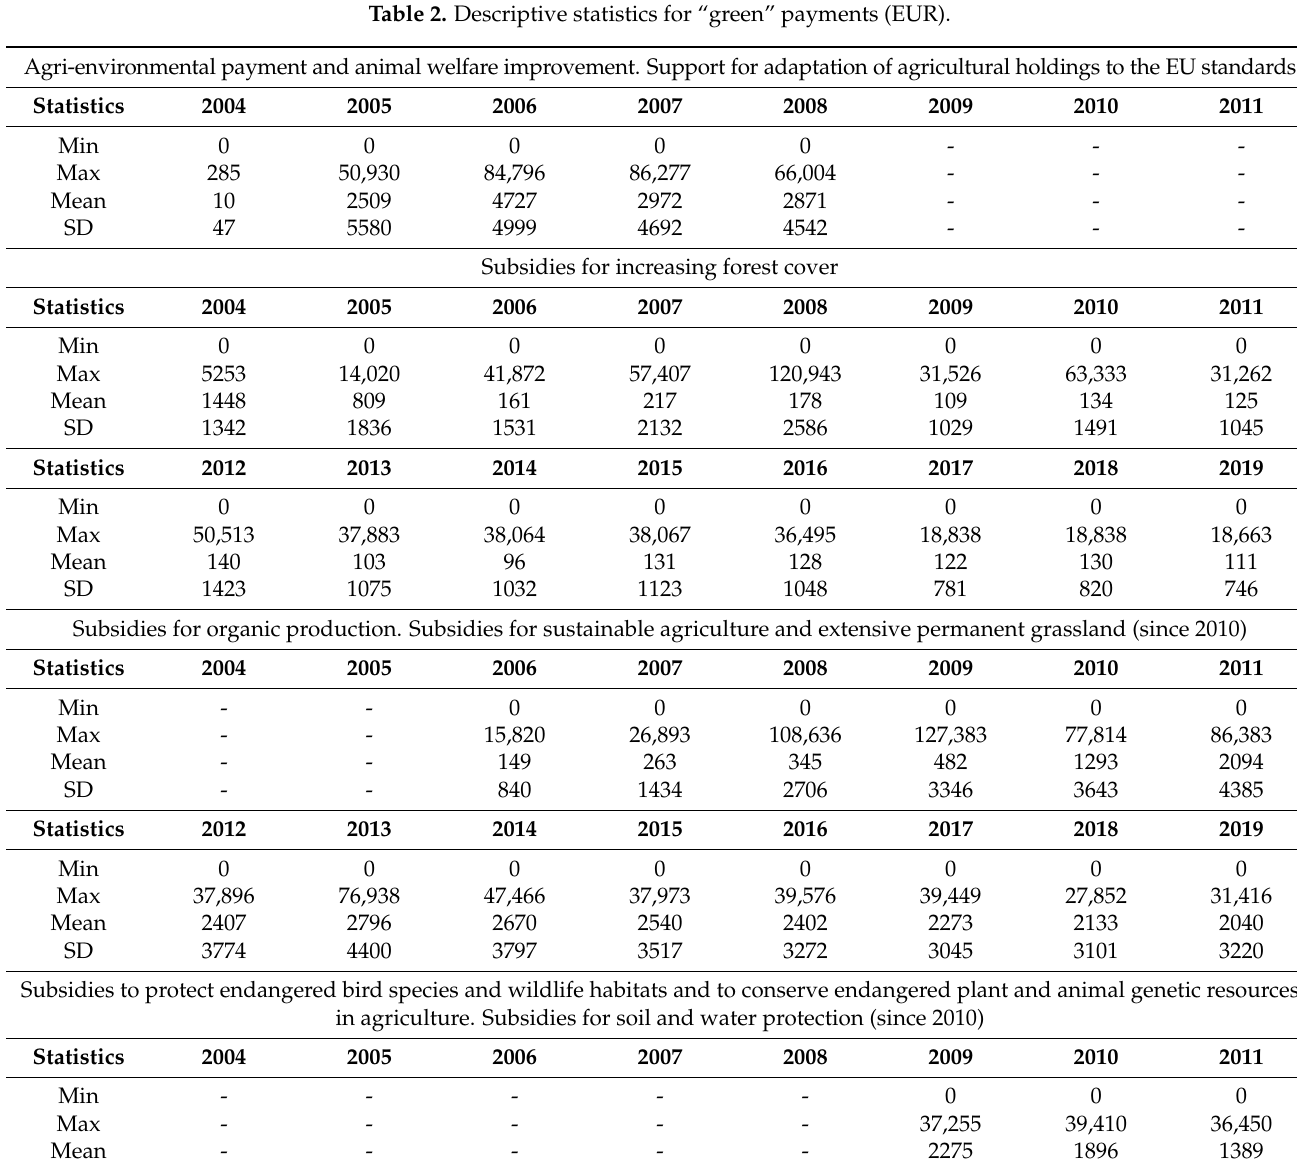
Table 2. Descriptive statistics for “green” payments